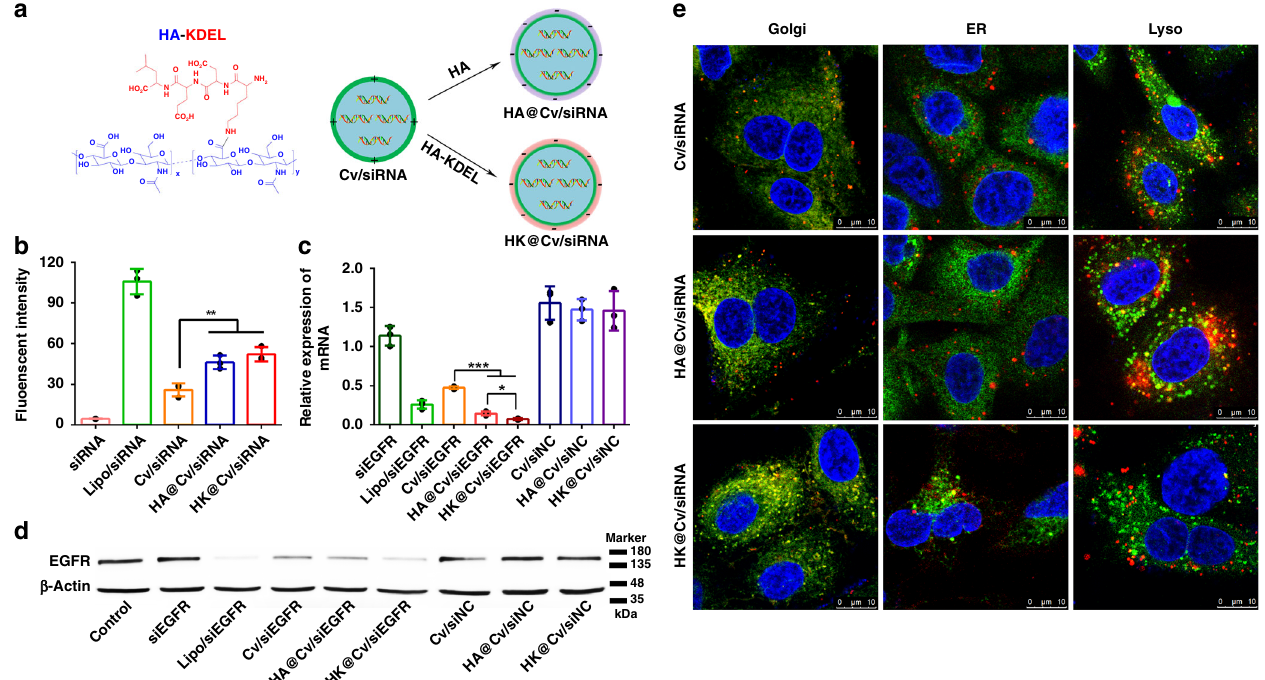
Fig. 7 Functional veri fi cation of endoplasmic reticulum (ER)-resident proteins. a Schematic illustration of the preparation of HA@Cv/siRNA and HK@Cv/ siRNA NPs; b Intracellular fl uorescence intensities in A549 cells detected by fl ow cytometry; c Relative levels of epidermal growth factor receptor (EGFR) mRNA detected by reverse transcriptase-PCR; d Expression levels of EGFR protein detected by western blot assay; e Intracellular fl uorescence colocalization of Cv/siRNA, HA@Cv/siRNA, and HK@Cv/siRNA NPs in Golgi, ER, and lysosomes, which were stained by Golgi-tracker, Alexa Fluor @ 568- labeled anti-KDEL, and anti @ M6PR antibody, respectively. The fi nal concentration of FAM-siNC, Cy5-siNC, and siEGFR were 100 nM. Data are shown as mean ± SD ( n = 3). * p < 0.05, ** p < 0.01, *** p <0.001, t